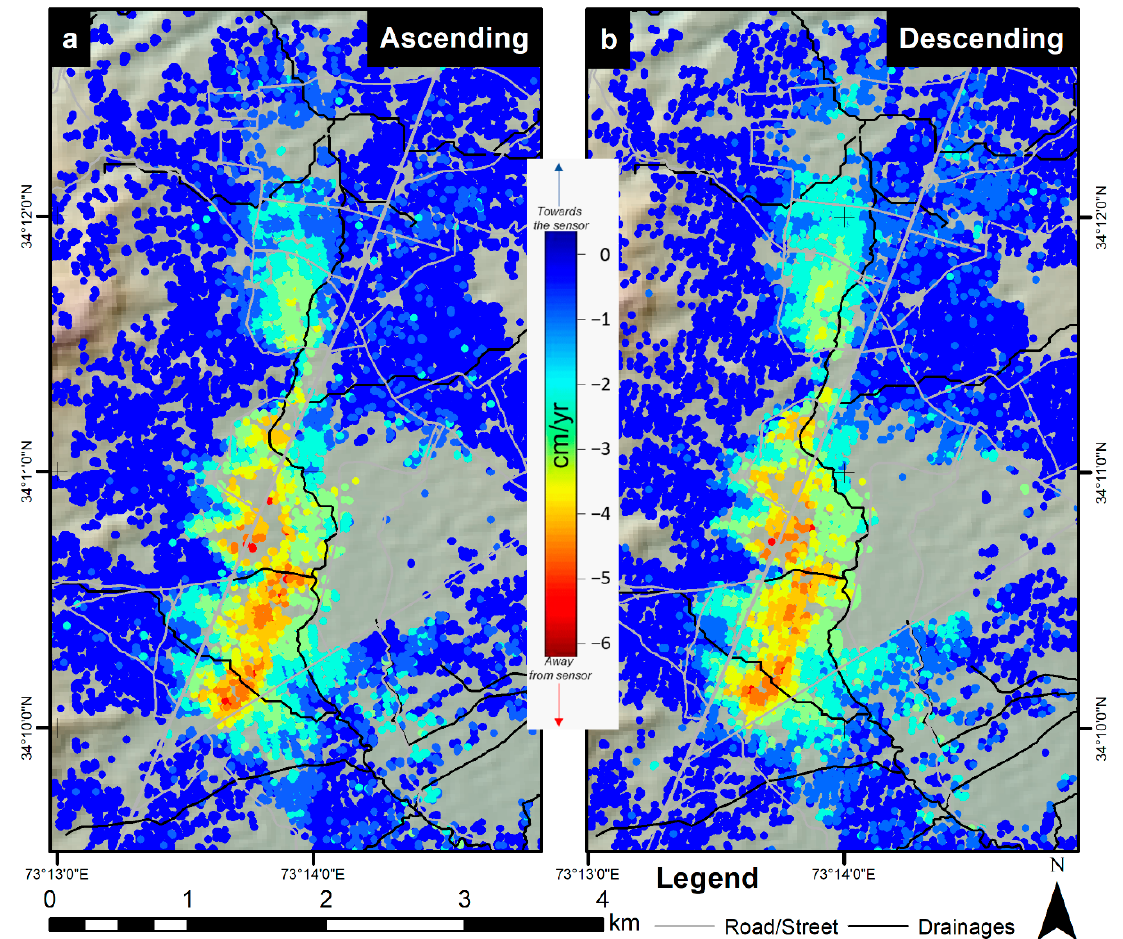
Figure 5. Average line of sight (LOS) velocity maps: ( a ) ascending and ( b ) descending orbits’ data.